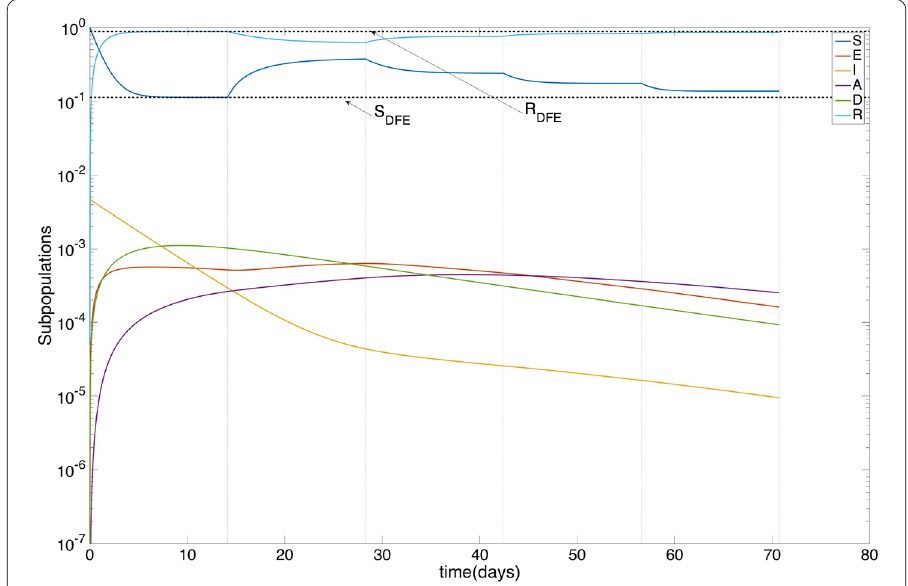
Figure 11 Dynamics of the subpopulations under supervised control